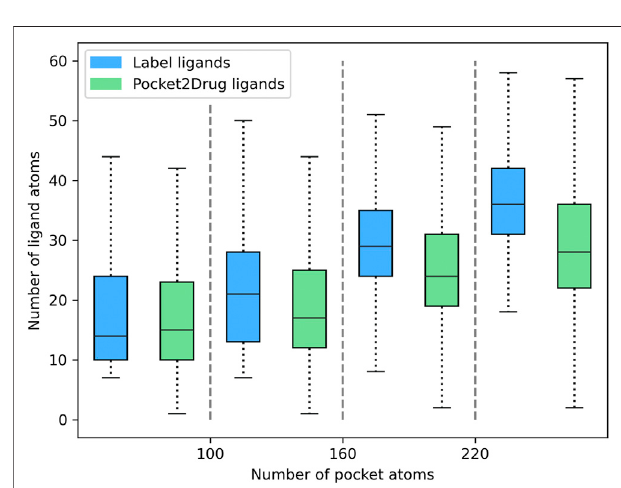
FIGURE 3 | Relationship between the ligand size and the size of binding pockets. The size of ligands and pockets is quanti fi ed by the number of non- hydrogen atoms. Binding pockets are assigned to four size groups: < 100, 100 – 160, 161 – 220, and > 220 atoms. For each pocket group, quartiles andtheinterquartilerangearecalculatedforthesizeoflabelligands(bluebars) and those molecules generated by Pocket2Drug (green